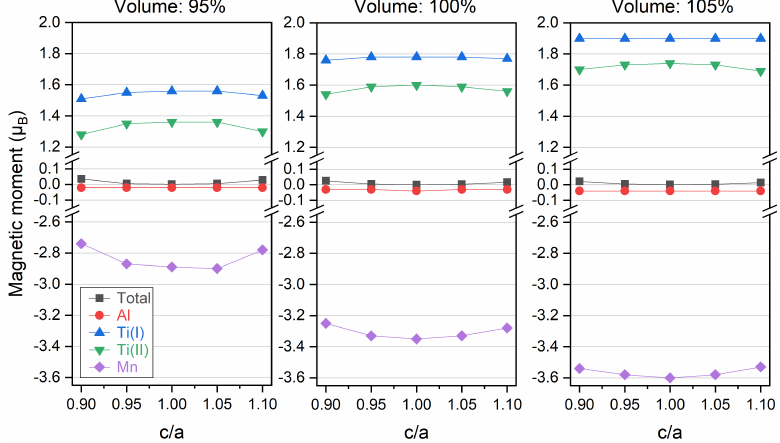
Figure 8. Total and atom-resolved magnetic moments of Ti 2 MnAl compound with different unit cell volume under tetragonal deformation of different c/a ratio. Atomic site is referred as the crystal structure in Figure